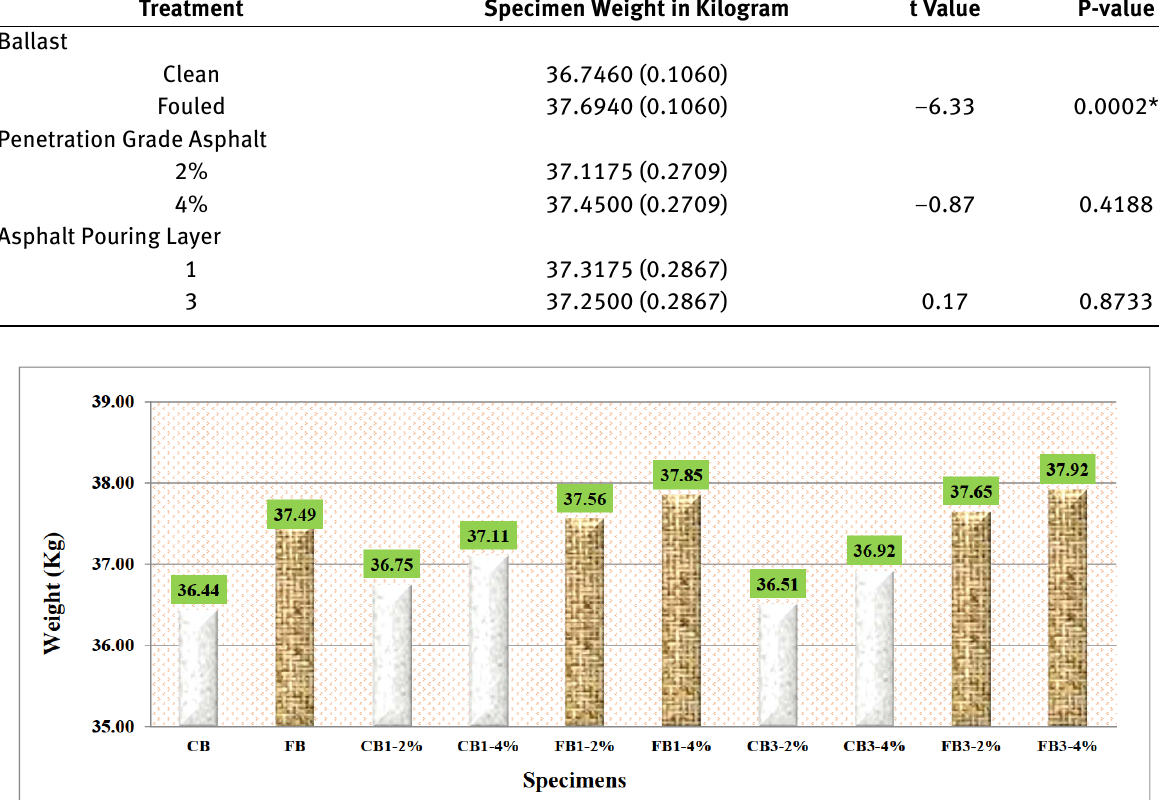
Table 4: Compared means of specimen